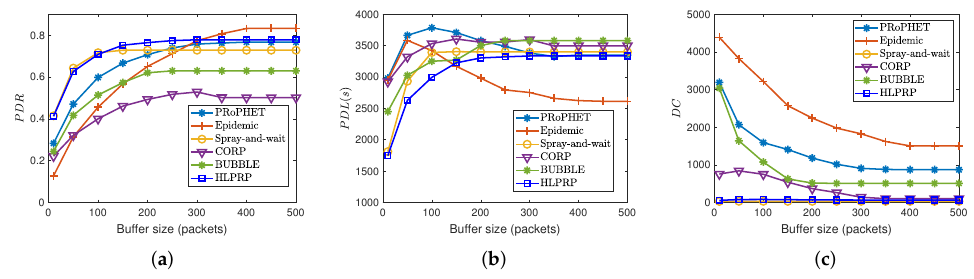
Figure 5. The network performance for various buffer sizes. ( a ) PDR . ( b ) PDL . ( c ) DC .